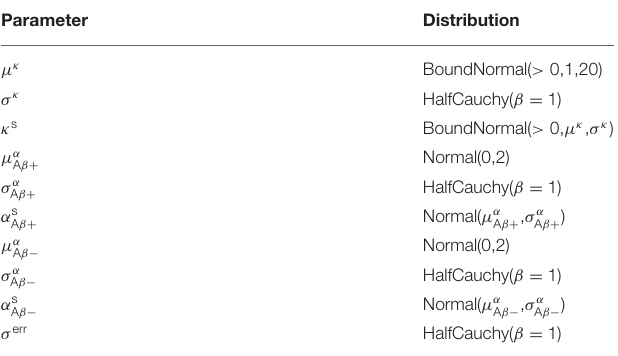
TABLE 1 | Hierarchical Bayesian inference.